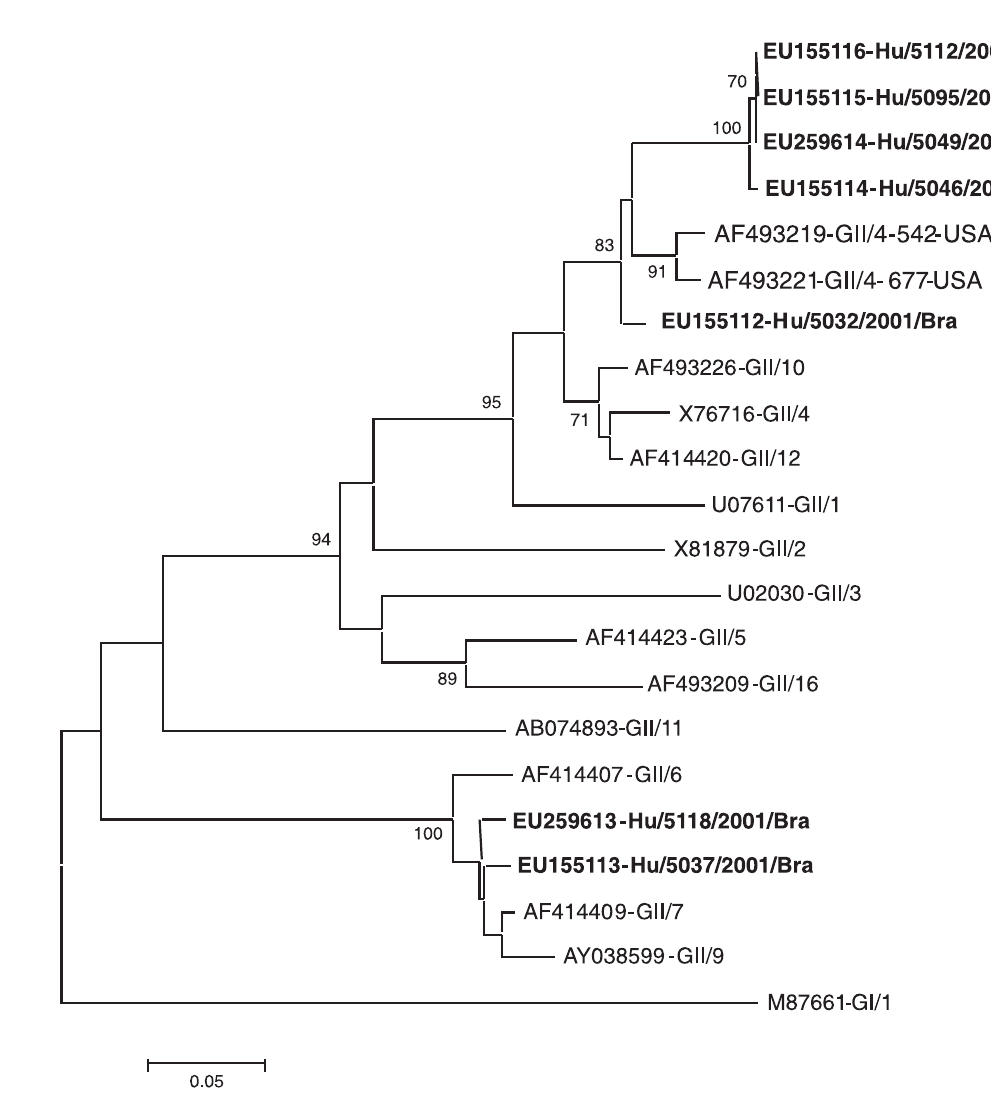
Salvador, BA, in 2001 and NoV genogroup GII reference strains (in bold). Outgroup: NoV genogroup GI (M87661). Our strain denominations: GenBank accession number followed by isolation, year and place strains. Prototype strains: GenBank accession number followed by genogroup/genotype. The scale bar indicates nucleotide substitutions per